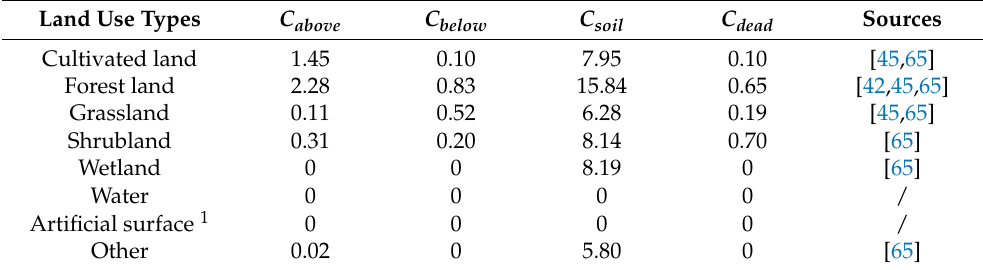
Table 2. Carbon densities of each land ues type (2020) used in InVEST model (kg/m 2